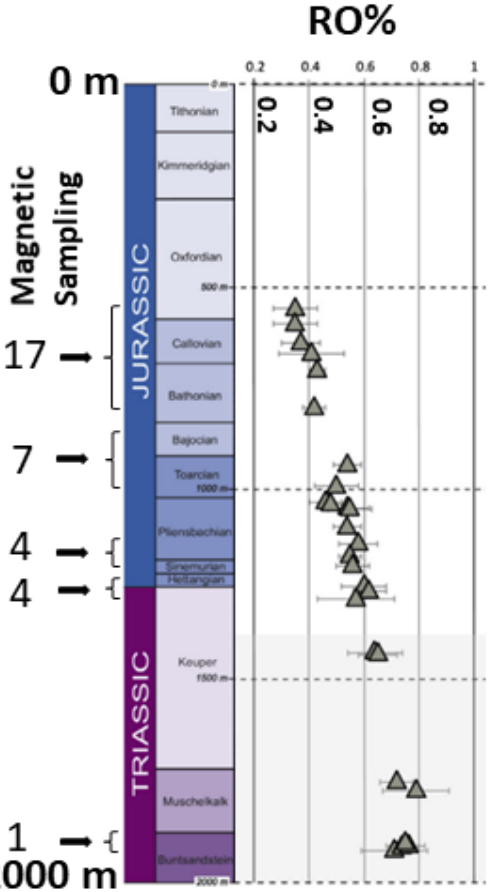
Figure 4. Peak burial temperature proxies from Borehole EST433. The reflectance of vitrinite (RO%) from ~0.3 to ~0.8 indicated that organic matter maturity was within the oil window. The numbers on the left refer to sampling for magnetic analysis. Data from Blaise et al. [8].